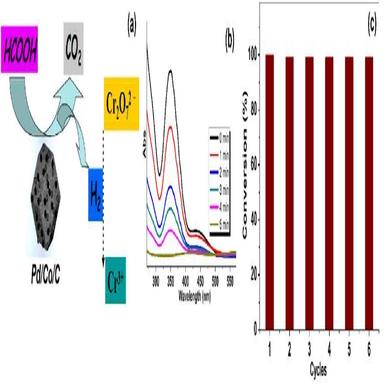
(a) Schematic illustration of the catalytic reduction of Cr(VI) on Pd/Co/C nanopolyhedra. (b) the catalytic reduction performance of Cr(VI) into Cr(III) by FA with 6 mg of Pd/Co/C, and (c) the Pd/Co/C as catalyst running through 6 recycles (.